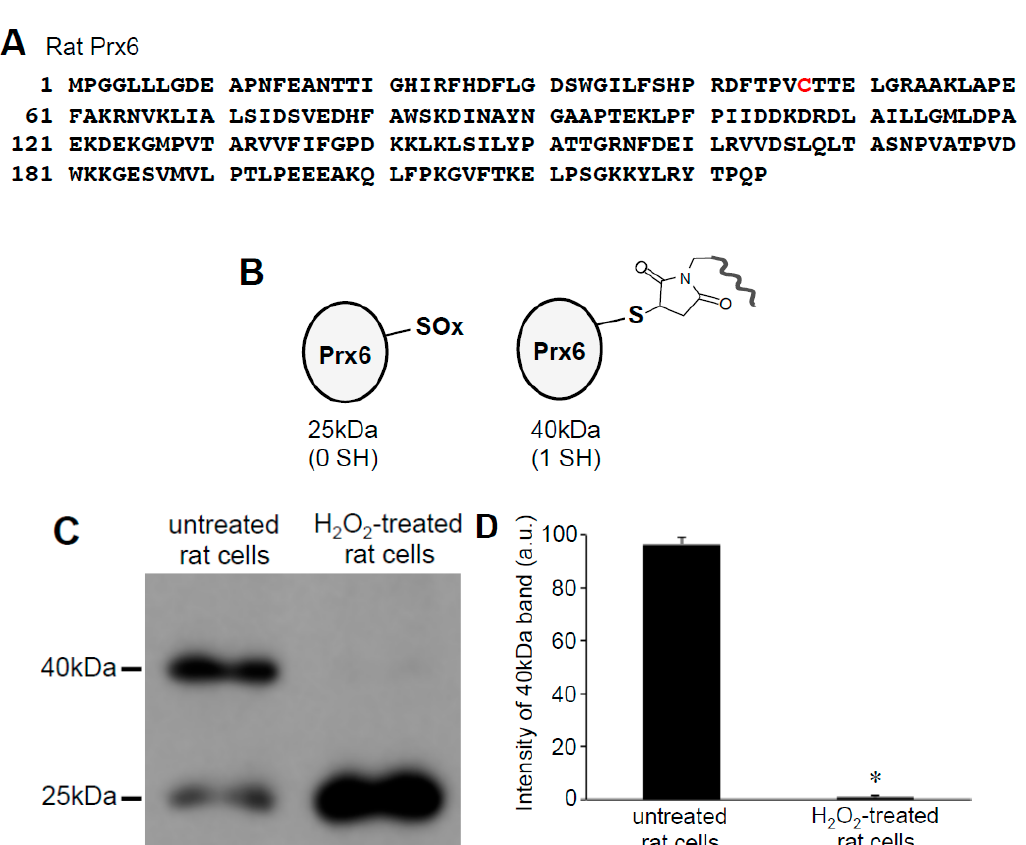
Figure 3. Effects of H 2 O 2 on thiol state of Prx6 in rat cells monitored using Protein-SHifter Plus. ( A ) Amino acid sequence of rat Prx6. Cys47 indicated in red is the conserved catalytic cysteine. ( B ) Schematics of the rat Prx6 structure with or without Protein-SHifter Plus attached. SOx indicates the oxidized cysteine that would not bind to the Protein-SHifter Plus. ( C ) Rat pulmonary artery smooth muscle cells were treated with or without H 2 O 2 (200 µ M) for 15 min. Cell lysates were prepared, incubated with Protein-SHifter Plus, subjected to SDS-PAGE without BME, and immunoblotted with the Prx6 antibody. ( D ) The bar graph represents the means ± SEM of the intensity of the 40 kDa band ( n = 3). The symbol * represents the value significantly different from the untreated control value at p < 0.05.